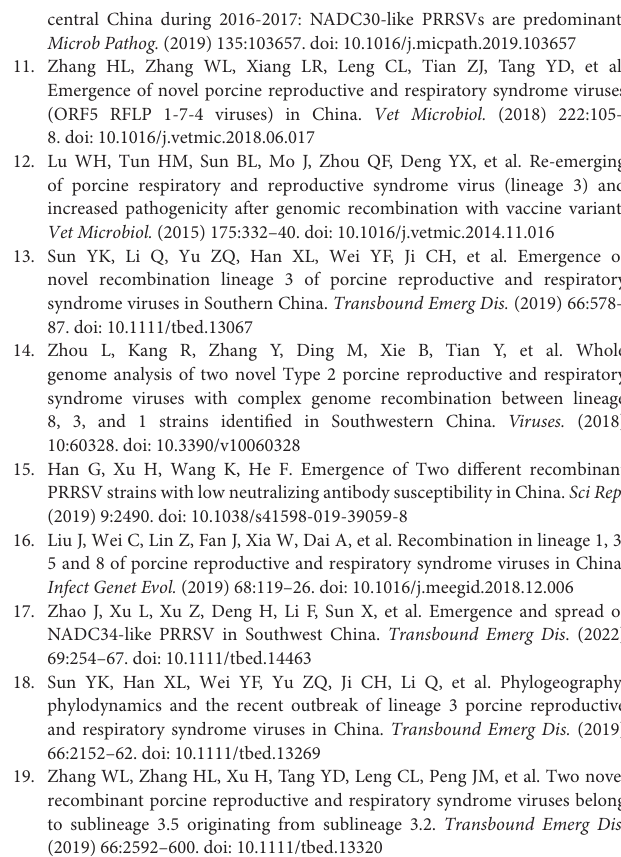
Supplementary Figure 1 | Recombination analysis of GXXNF10-1803, GXXNF53-1805, GDXNF60-1805, GXXNF74-1806, GXXNF78-1806, GDXNF229-1811, HNLCL15-1903, HNTZJ1714-2011, and GXTZJ2325-2112. Phylogenic trees were constructed based on different parent regions. Blue represents HP-PRRSV, yellow represents NADC30-like PRRSV, and red represents QYYZ-like PRRSV. Supplementary Figure 2 | Summary of recombination breakpoints of all reported QYYZ strains in China. (A) The number of recombinant fragments provided by QYYZ in each region of 37 recombinant strains. The ORF5 of all 37 recombinant strains was provided by the QYYZ strain, while the Nsp1 region was provided by the QYYZ strain in only two strains. (B) Recombination breakpoints identified across the full-length genome. The putative recombinants are listed in the key, with the red triangles matching each corresponding breakpoint. Most breakpoints were localized in Nsp2 and GP2, and the backgrounds of the two regions are highlighted in